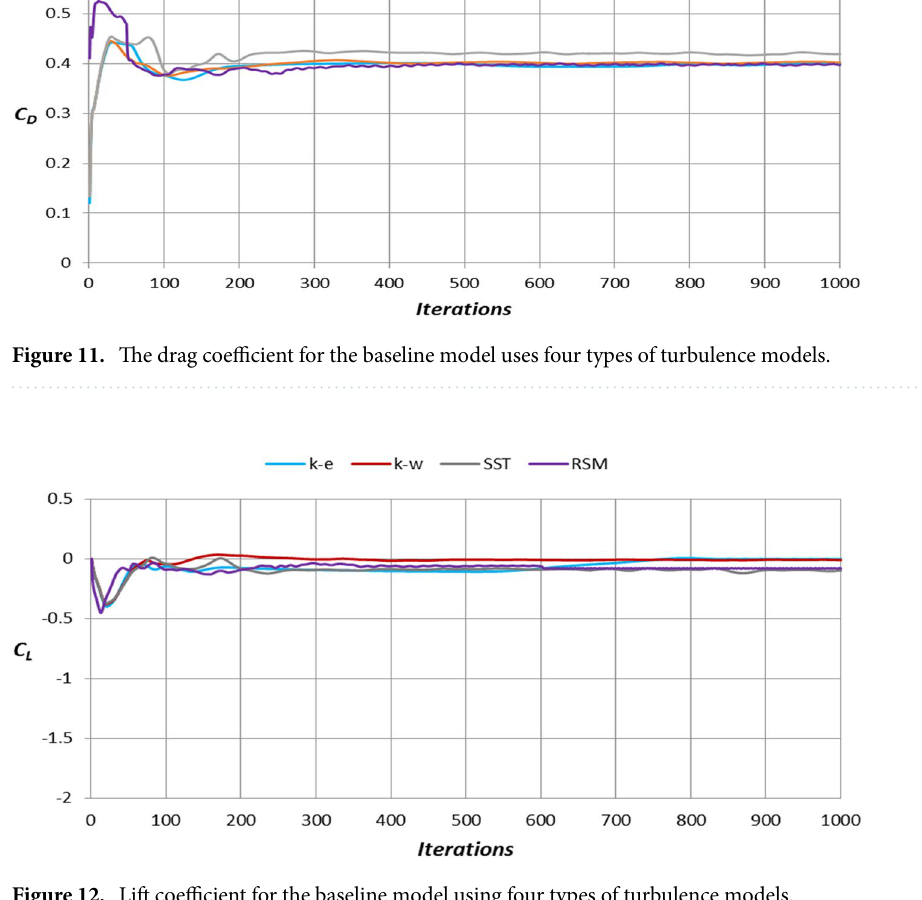
Figure 12. Lift coefficient for the baseline model using four types of turbulence models.